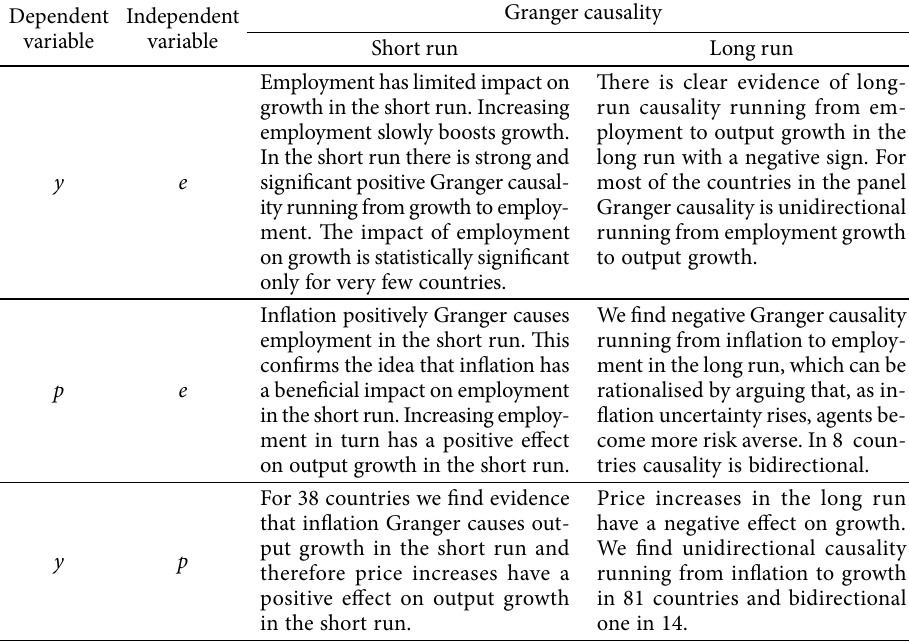
Table 5. Summary of the findings from the Panel Granger Causality Analysis Dependent